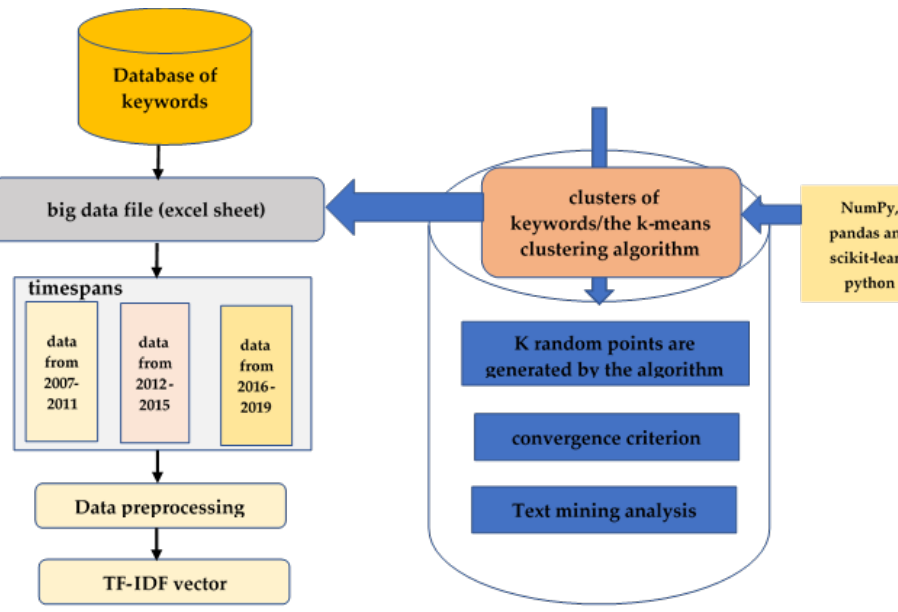
Figure 4. Flow diagram of the entire approach.